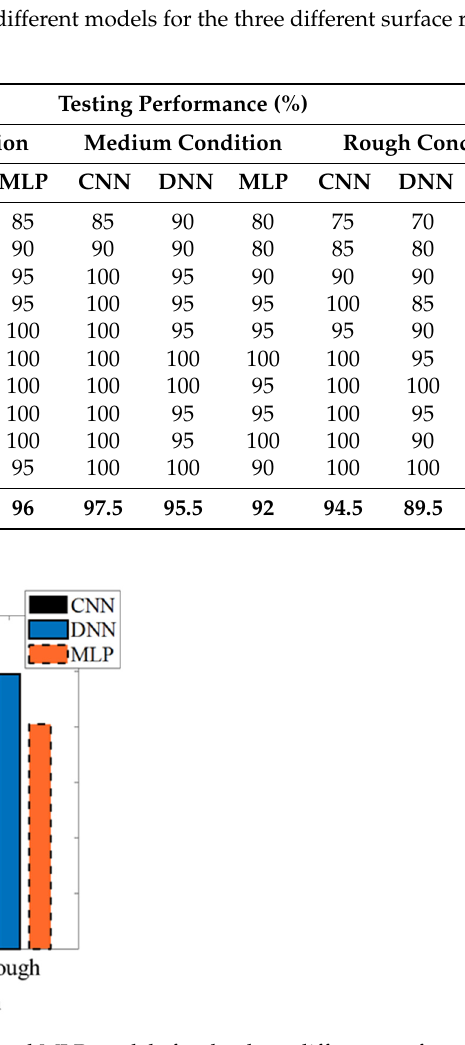
Figure 7. Learning curves of the ( a ) CNN, ( b ) DNN, and ( c ) MLP models for the “rough condition”, showing the testing accuracy and cost with respect to the number of epochs.